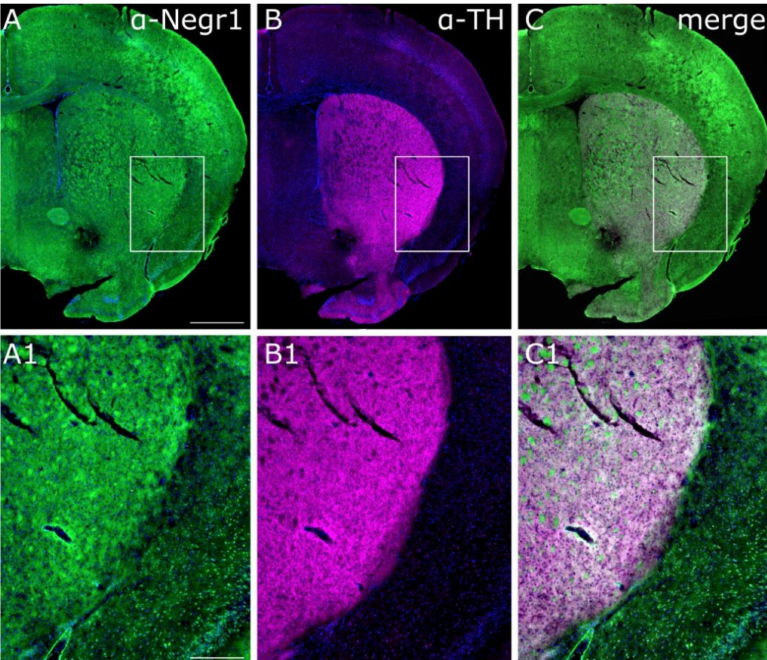
Figure 5. Expression of NEGR1 and TH in the striatum. Representative confocal images of the striatum show co-immunohistochemical stainings of anti-NEGR1 in green ( A , A1 ), with anti-tyrosine hydroxylase in magenta (TH) ( B , B1 ) and NEGR1 staining in the vicinity of dopaminergic projec- tion area can be seen with white color merged images ( C , C1 ). Boxed areas show the localization of the close-ups in the images ( A1 – C1 ). Scale bars: ( A – C ) 1 mm, ( A1 – C1 ) 300 µ m.